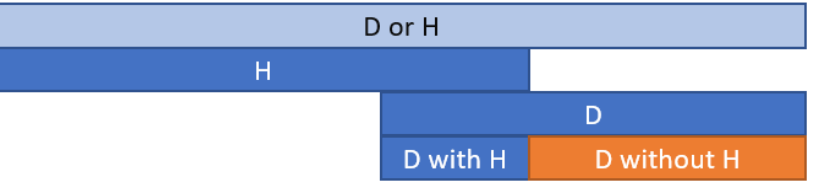
Table 1 . The characteristics of trials included in the analysis.